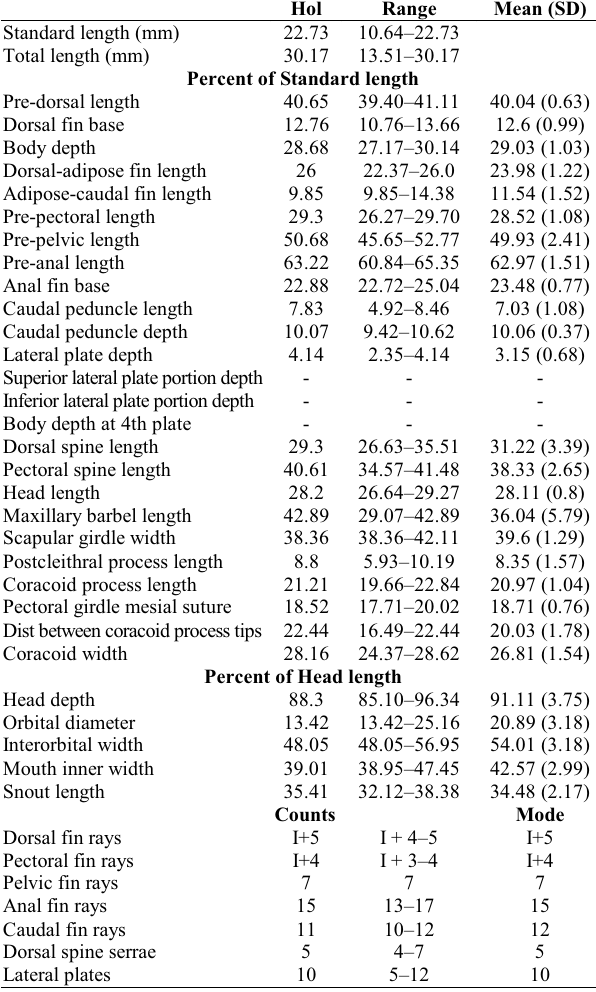
Table 3. Descriptive morphometrics and counts of Physopyxis cristata (N = 10). SD = Standard deviation. Hol =